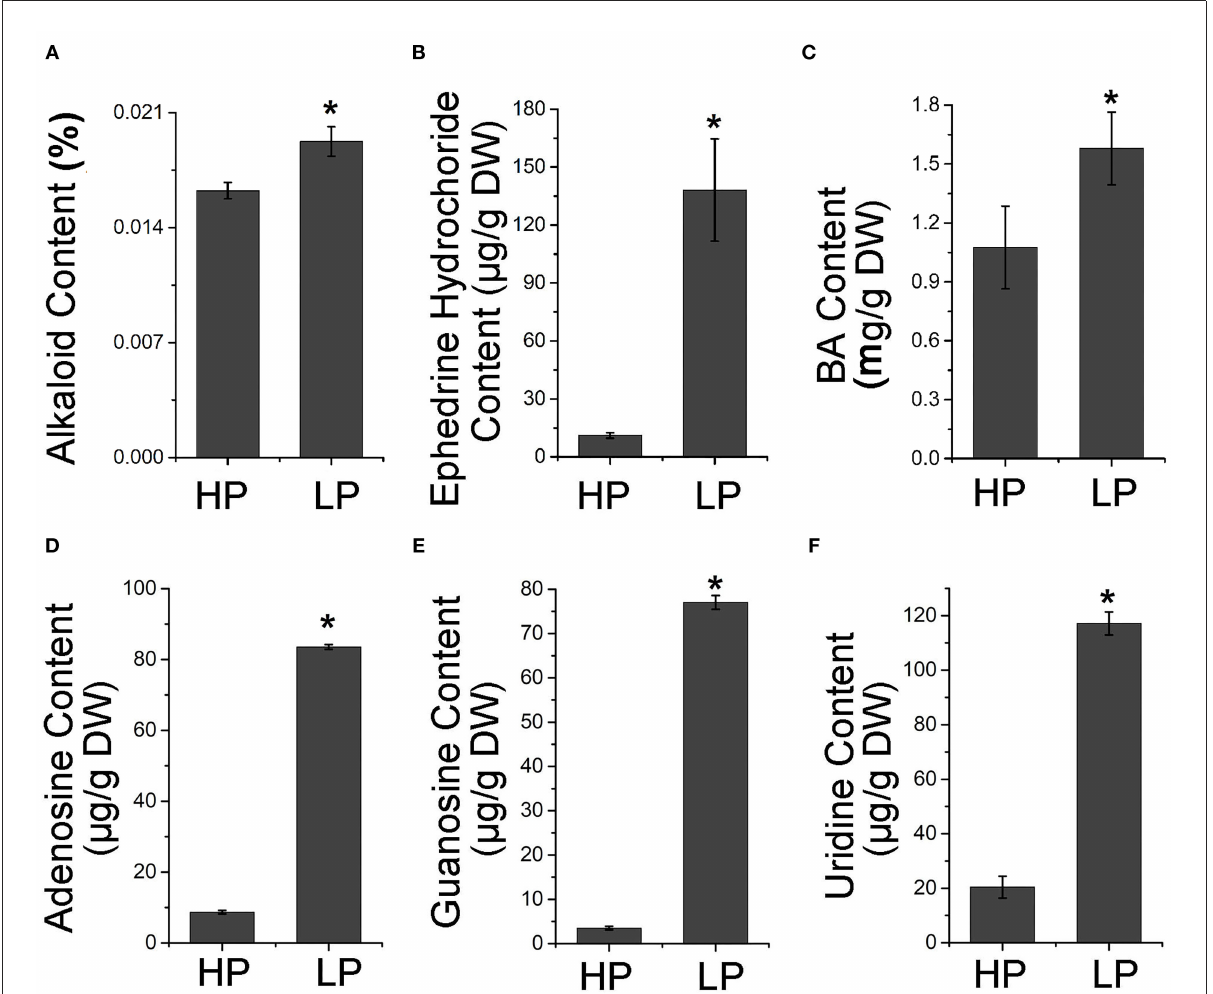
FIGURE3 Accumulation of alkaloid compounds by Pi starvation treatment. Contents of total alkaloid (A) , ephedrine hydrochloride (B) , BA (C) , guanosine (D) , adenosine (E) , and uridine (F) in tubers of P. ternata grown in high and low Pi for 7 days. Values are means ± SD of three biological replicates. *Indicates a significant difference between high/low Pi treatment at P < 0.05 by Student’s t -test. DW, dry weight. HP: high Pi, 10mM. LP: low Pi, 10 µ